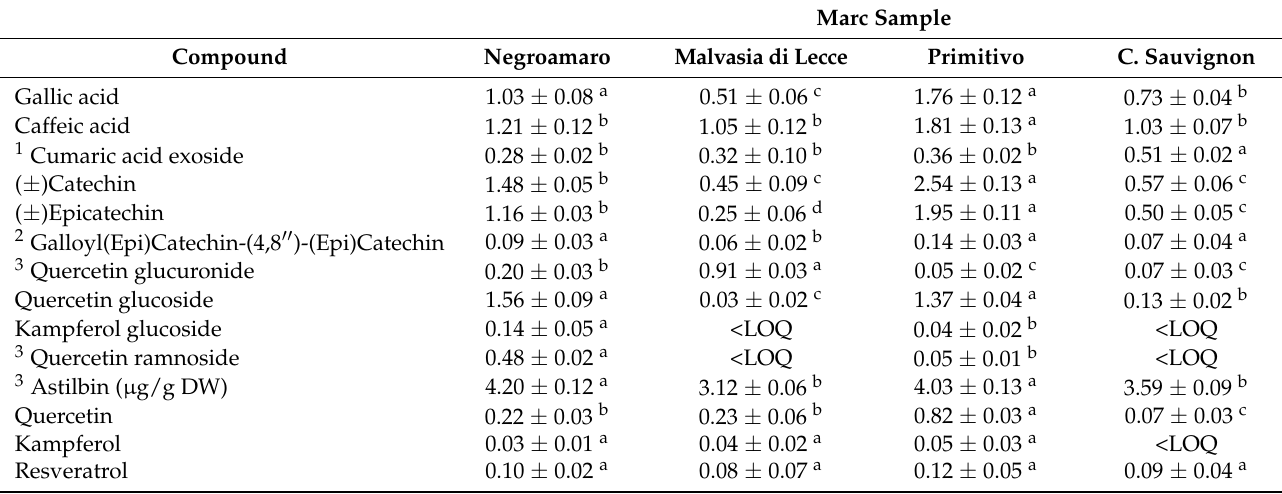
Table 5. HPLC/MS quantification of the main polyphenolic compounds in the grape marcs, reported as mg/g DW.